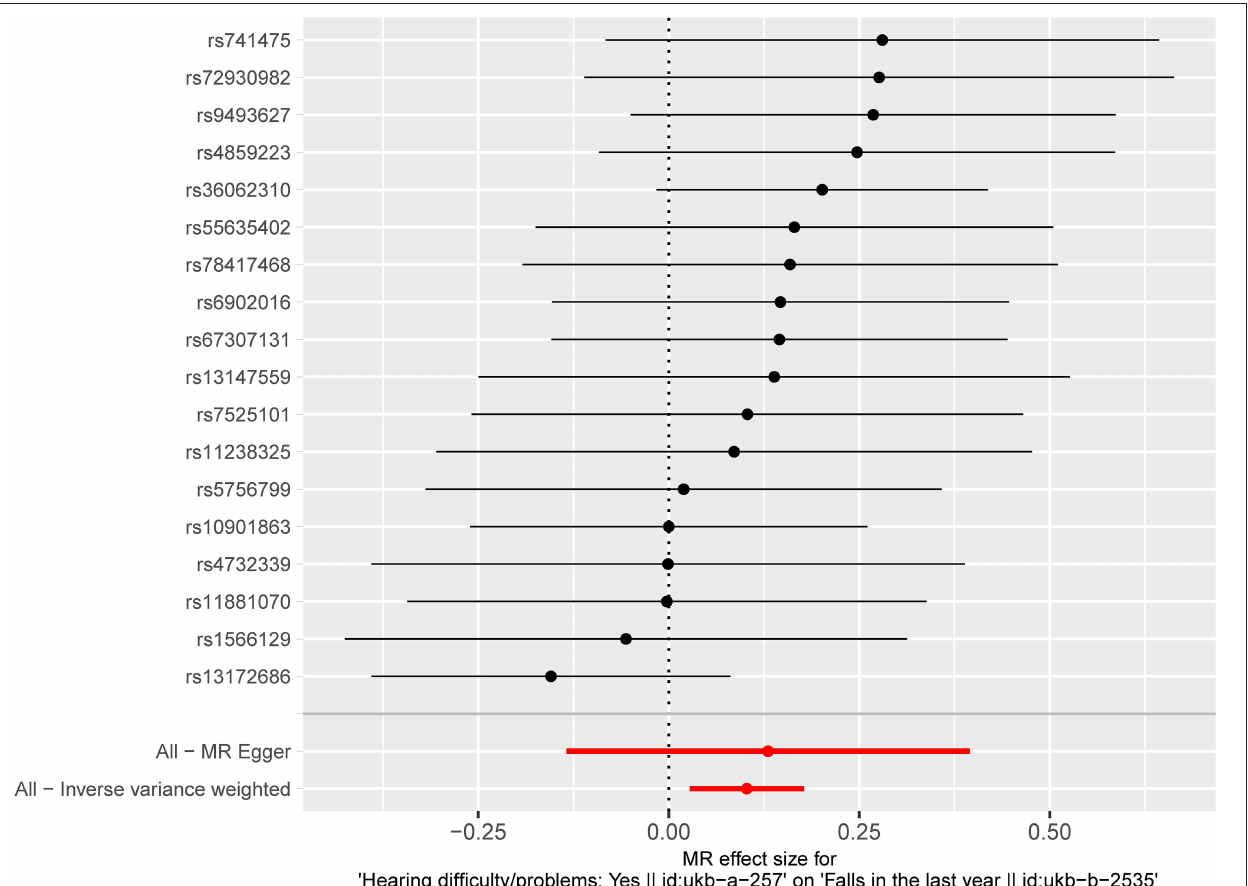
FIGURE 3 | Fixed-effect IVW analysis of the causal association of HI with falls. The black dots and bars indicate the causal estimate and 95% CI using each SNP. The red dot and bar indicate the overall estimate and 95% CI meta-analyzed by fixed-effect IVW method. IVW, inverse-variance weighted; HI, hearing impairment; CI, confidence interval; SNP, single nucleotide